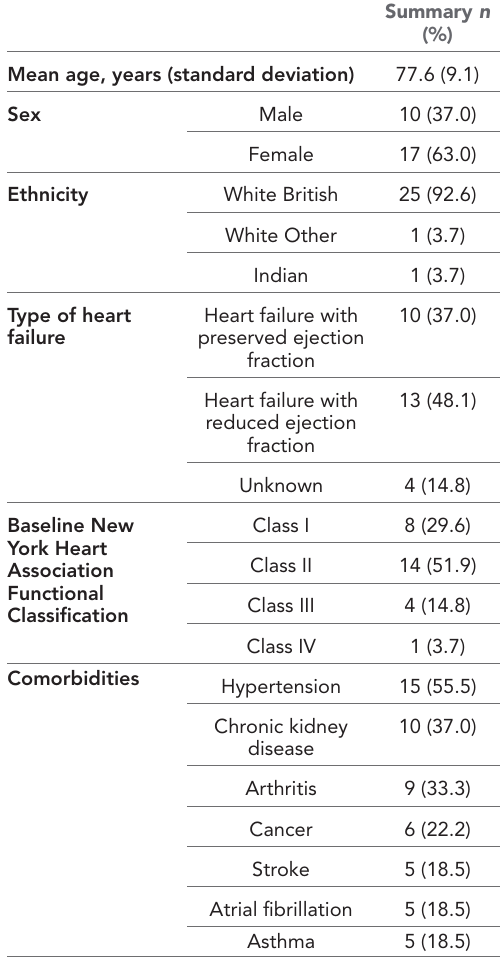
Table 1 Study inclusion and exclusion